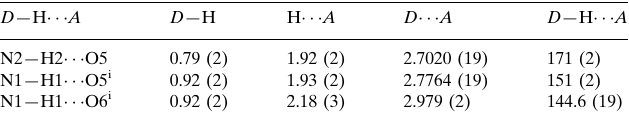
Hydrogen-bond geometry (A˚ , (cid:3)